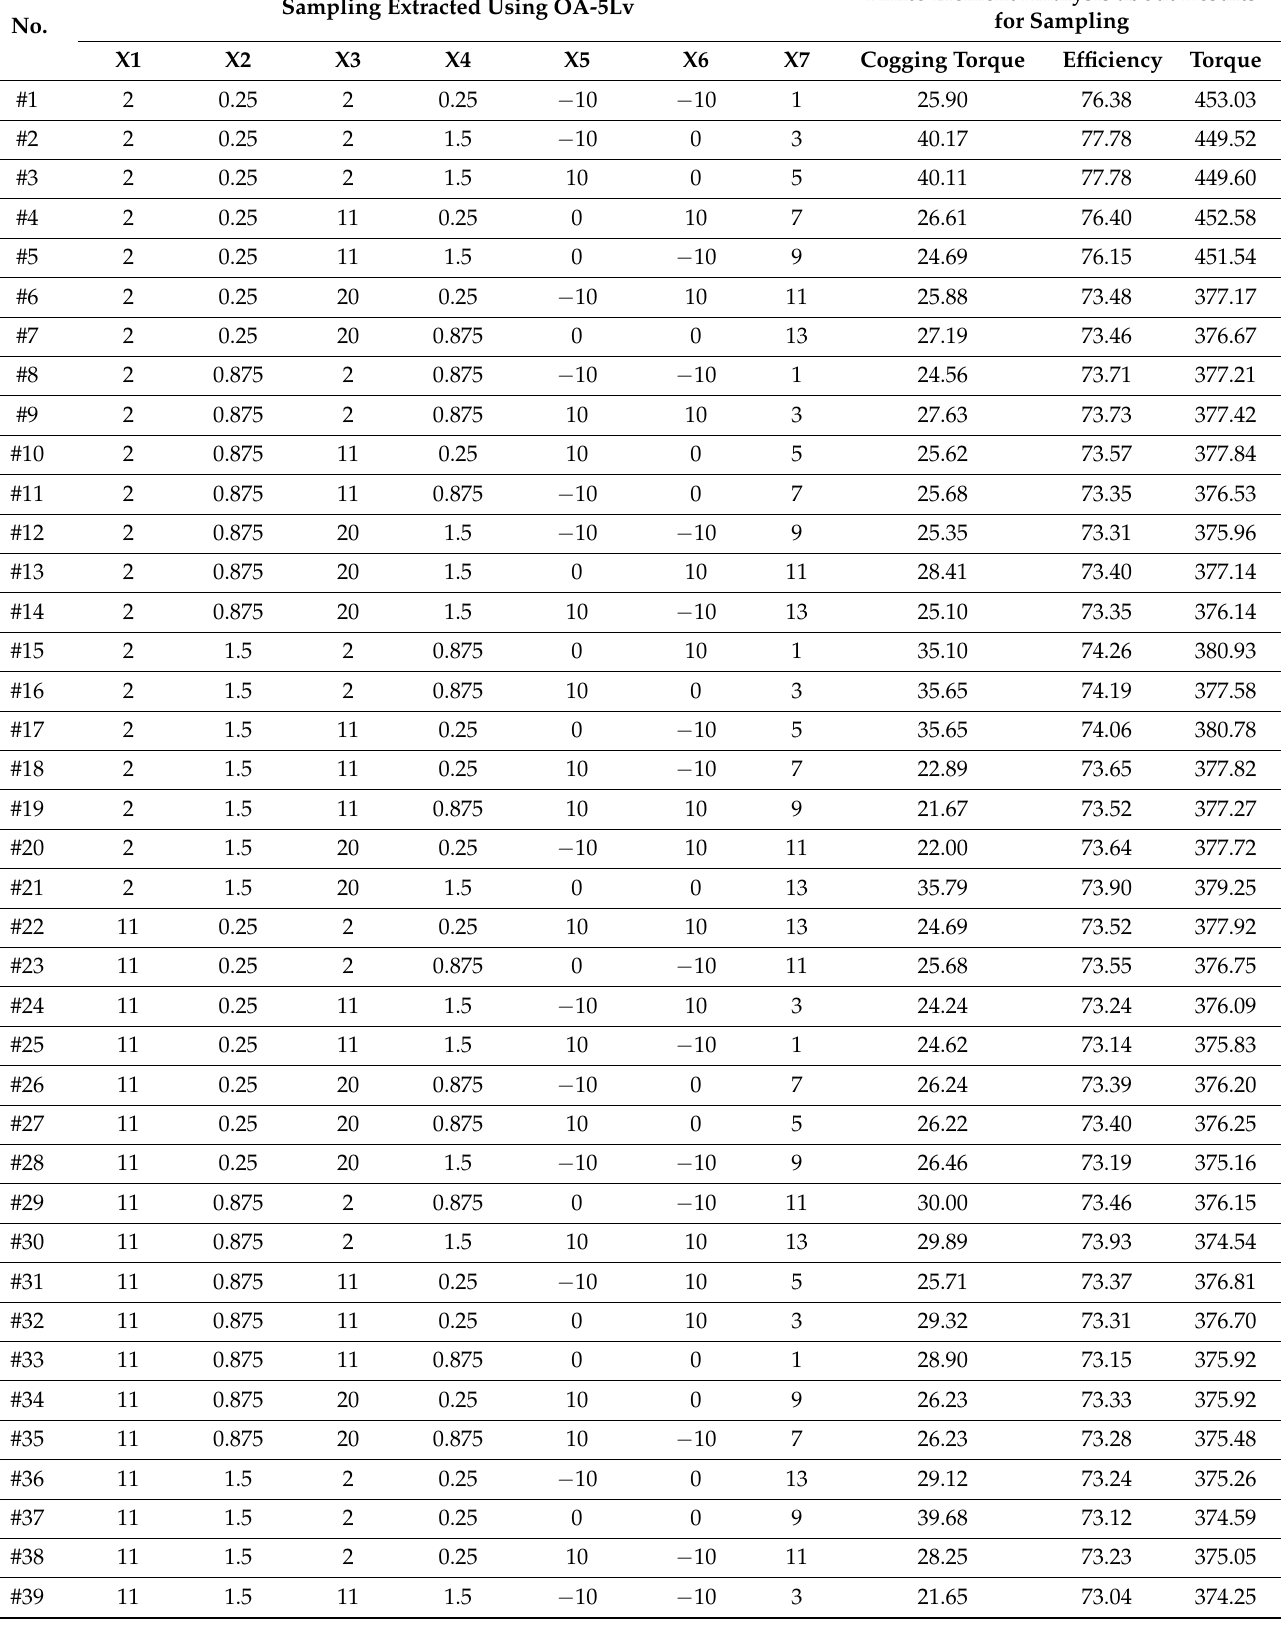
Table 3. Specifications of the single-phase BLDC